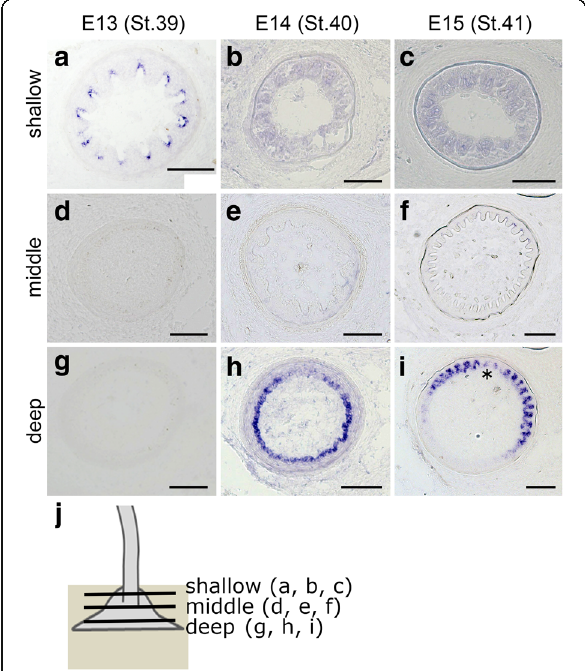
Fig. 4 Shh expression detected by section in situ hybridization in the FFF region. Cross sections around the bottom region of feather buds in the FFF region at E13 ( a , d and g ), E14 ( b , e and h ) and E15 ( c , f and i ) at shallow ( a – c ), middle ( d – f ) and deep ( g – i ) levels under the skin. Asterisk in i indicates an irregular pattern of shh expression that represents the position of the prospective rachis. j . an illustrated image showing positional relation of sections ( a – i ) along depth direction. Scale bars: 100 μ